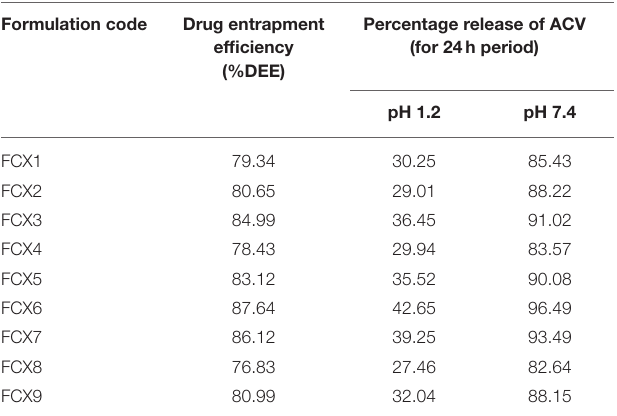
Formulation code